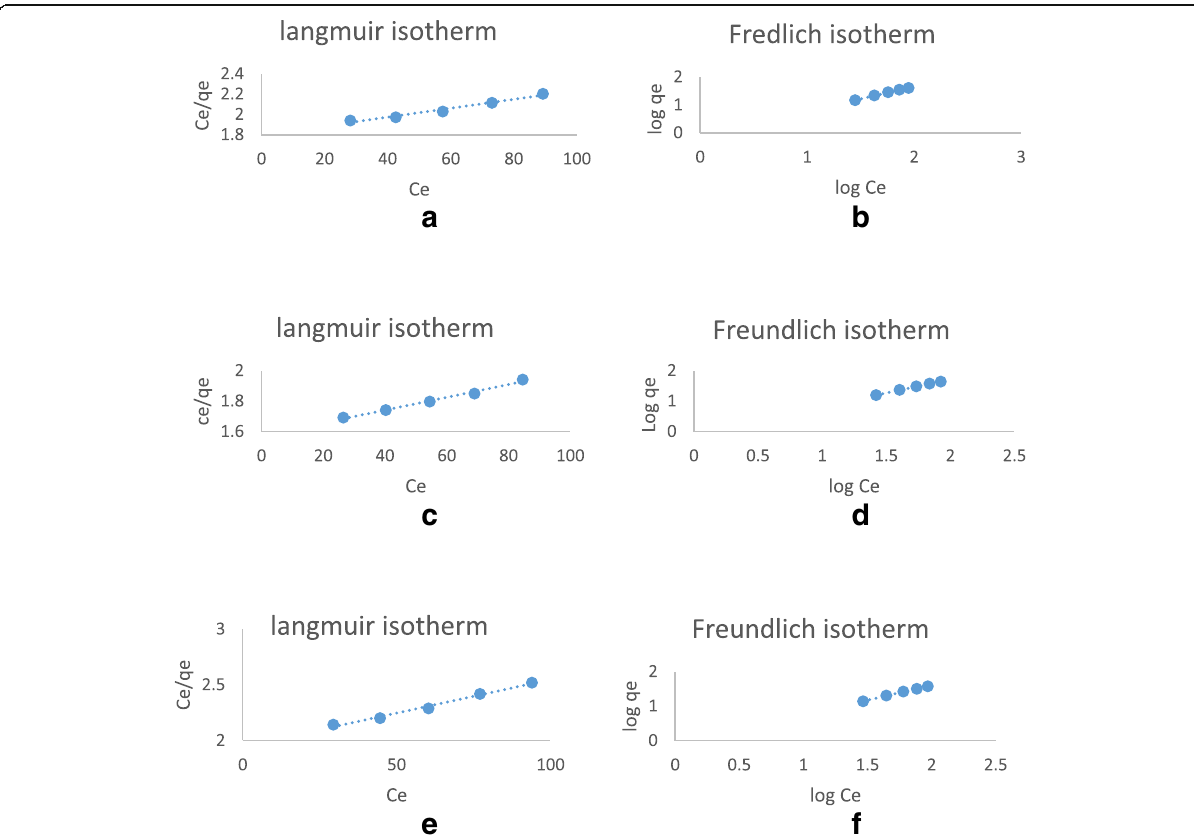
Fig. 7 a Langmuir adsorption isotherm of cefadroxil, b Freundlich adsorption isotherm of cefadroxil, c Langmuir adsorption isotherm of cefprozil, d Freundlich adsorption isotherm of cefprozil, e Langmuir adsorption isotherm of cefradine, and f Freundlich adsorption isotherm of cefradine on MSN at optimum conditions